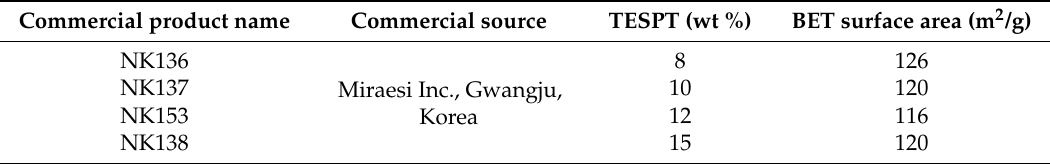
Table 1. BET surface area of TESPT modified silica according to TESPT